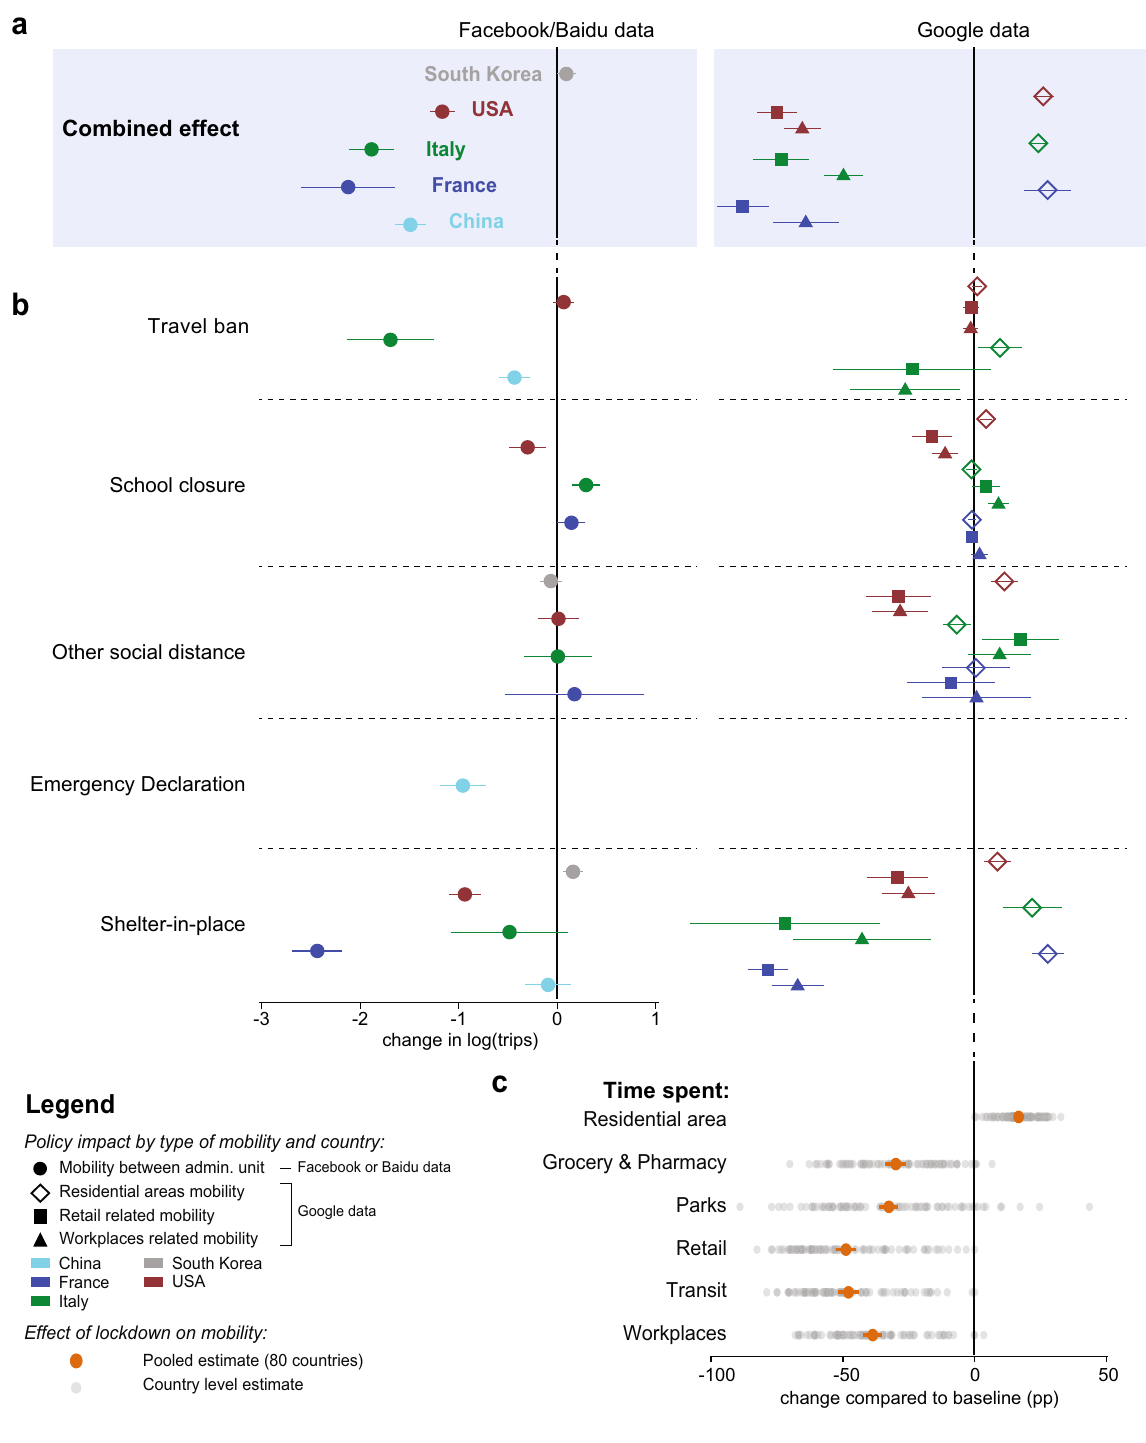
Figure 2. Empirical estimates of the effect of NPIs on mobility measures. Markers are country specific- estimates, whiskers show the 95% confidence interval. ( a ) Estimated combined effect of all policies on number of trips between counties (left) and time spent in specific places (right). ( b ) Estimated effects of individual policy or policy groups on mobility measures, jointly estimated for each country. ( c ) Estimated effect of lockdown on mobility the 80 countries which experienced such policy, jointly estimated for each type of